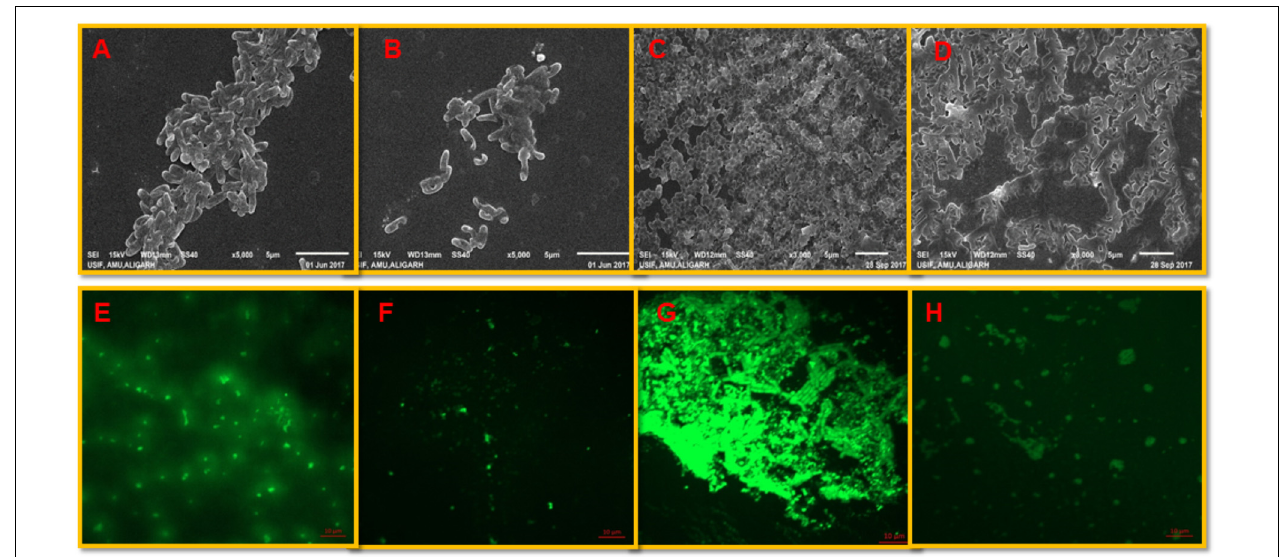
FIGURE 5 | Visualization of biofilm inhibition. P. aeruginosa biofilm: (A,B) shows untreated controls and cells treated with 1/2 × MIC of IONPs as seen by the SEM (E,F) control and treated biofilms stained with acridine orange and visualized by CLSM. L. monocytogenes biofilm: (C,D) shows untreated controls and cells treated with 1/2 × MIC of IONPs as seen by the SEM (G,H) control and treated biofilms stained with acridine orange and visualized by